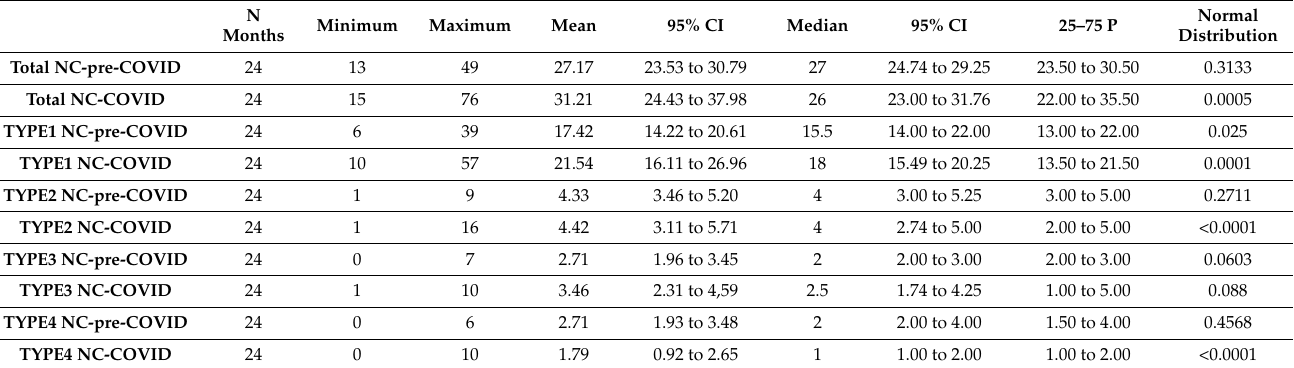
Table 1. Summary statistical value reporting the range (minimum and maximum), the mean, the median with calculation of the 95% CI; the 25–75th percentile of the normal distribution